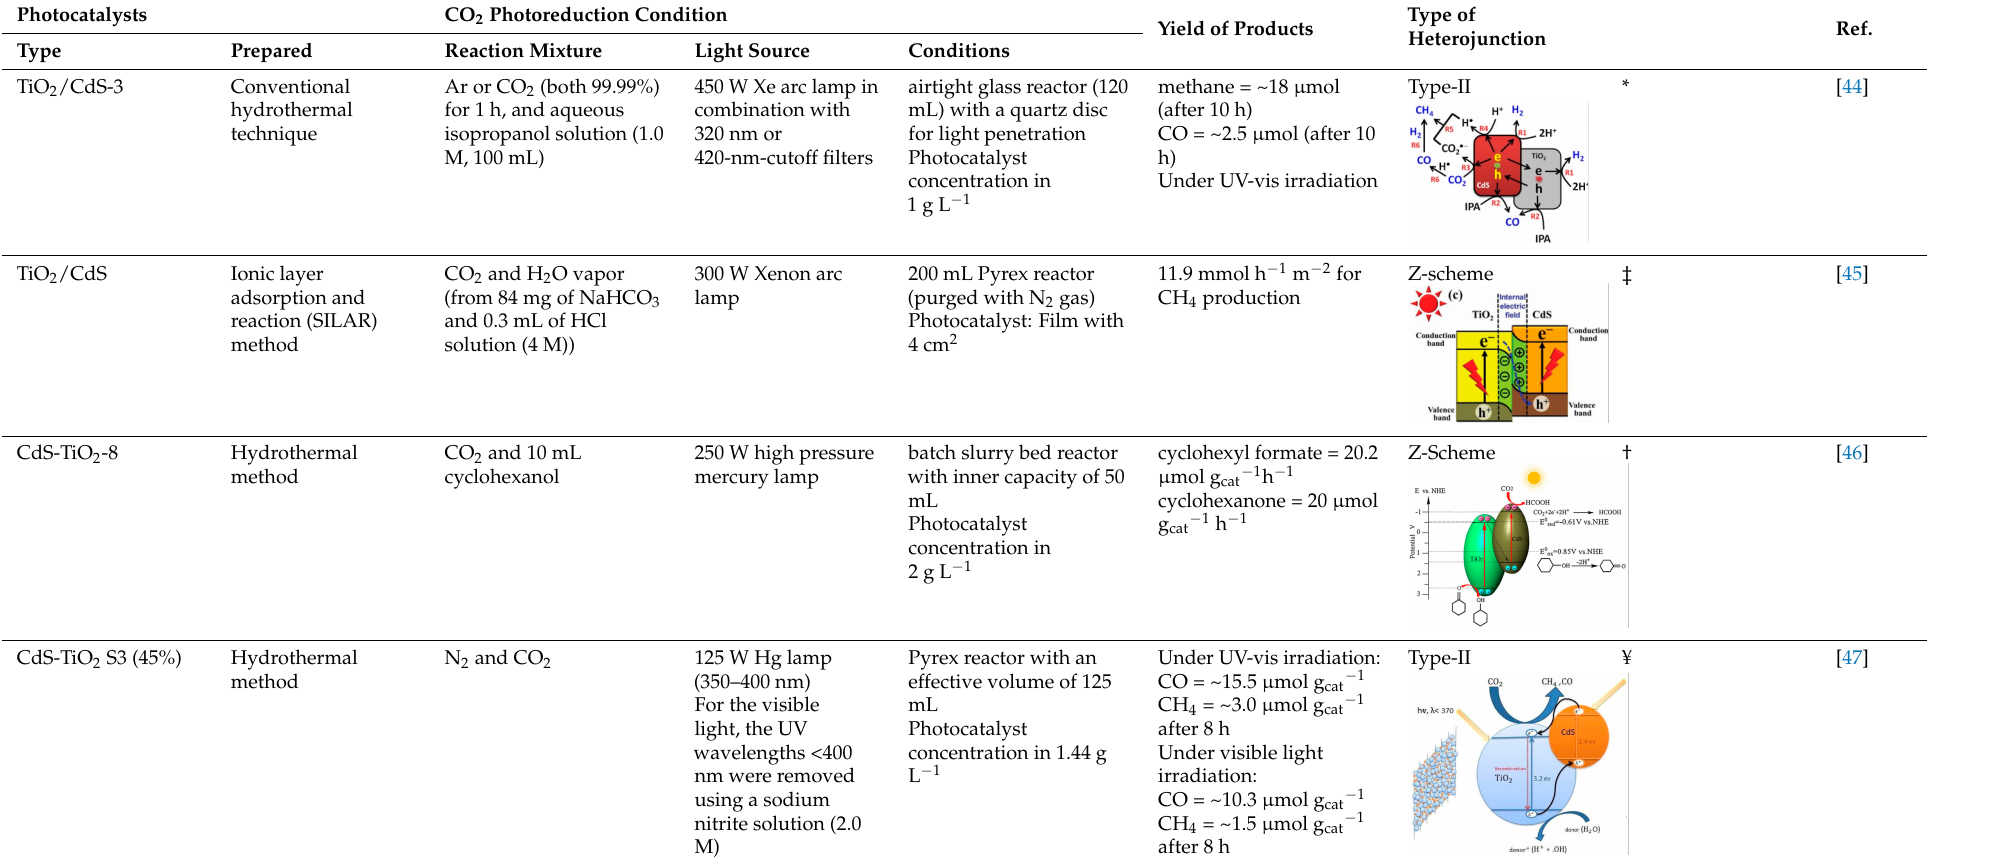
Table 5. CO 2 photoreduction using CdS/TiO 2 heterojunction